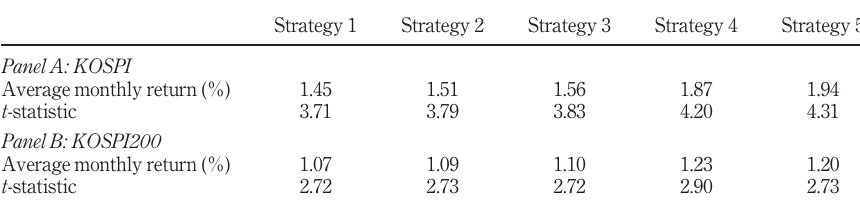
Table 5. Performance of style timing strategies based on cross- sectional